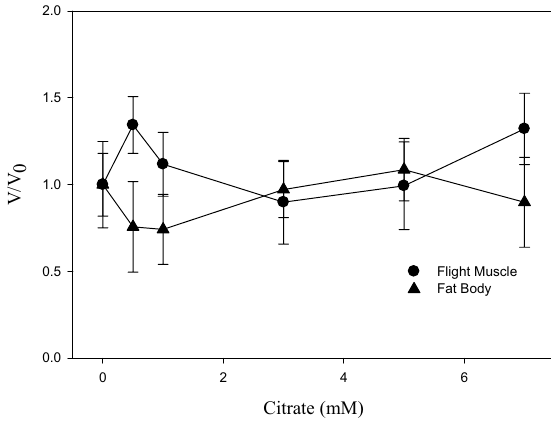
Fig. 4– EffectsofsodiumcitrateonPFKactivityfromfatbodyand muscle homogenates. PFK activity of flight muscle (filled triangles) or fat body (filled triangles) was measured as described on Materials and Methods, in the presence of 5 mM fructose 6-phosphate and 4 mM ATP. Values are means ± SE of at least six independent experiments.